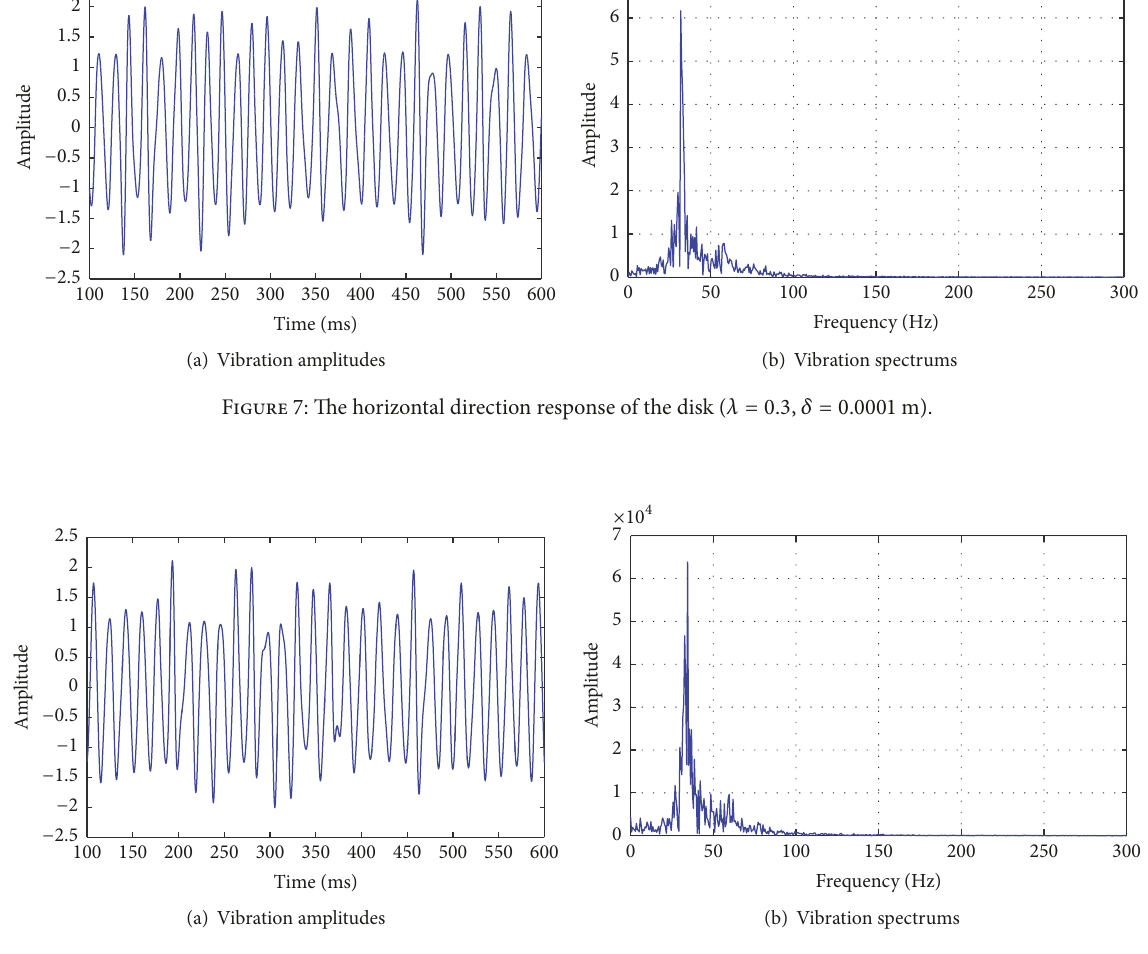
Figure 8: The horizontal direction response of the disk ( 𝜆 = 0.5 , 𝛿 = 0.0001 m).